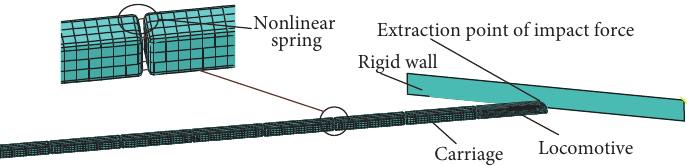
Figure 9: 3D FE model of a typical train configuration [15].